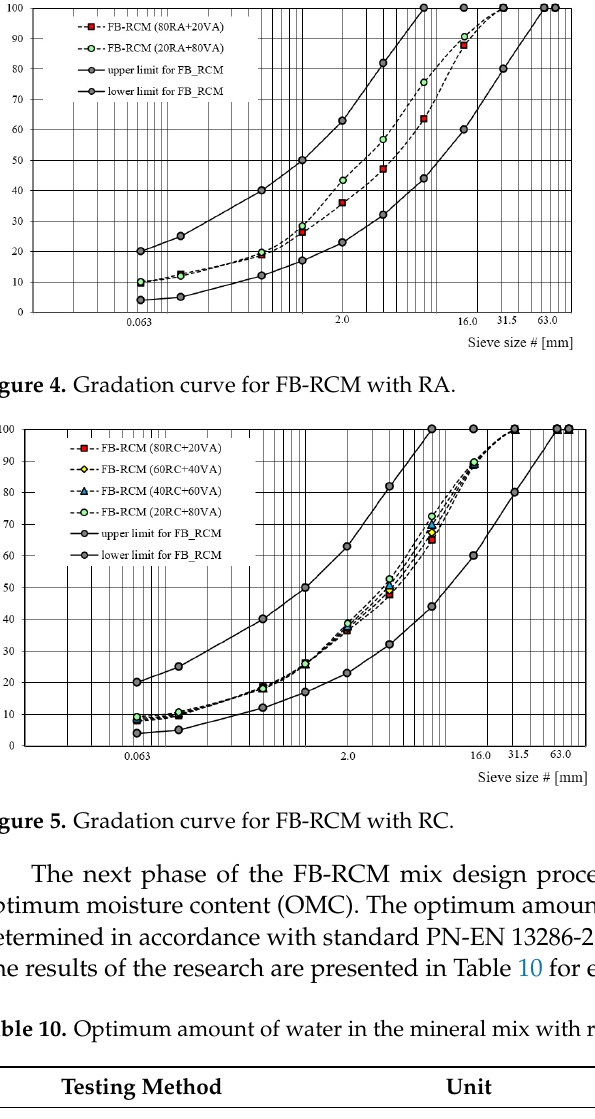
Figure 3. Gradation curve for FB-RCM with RAP.